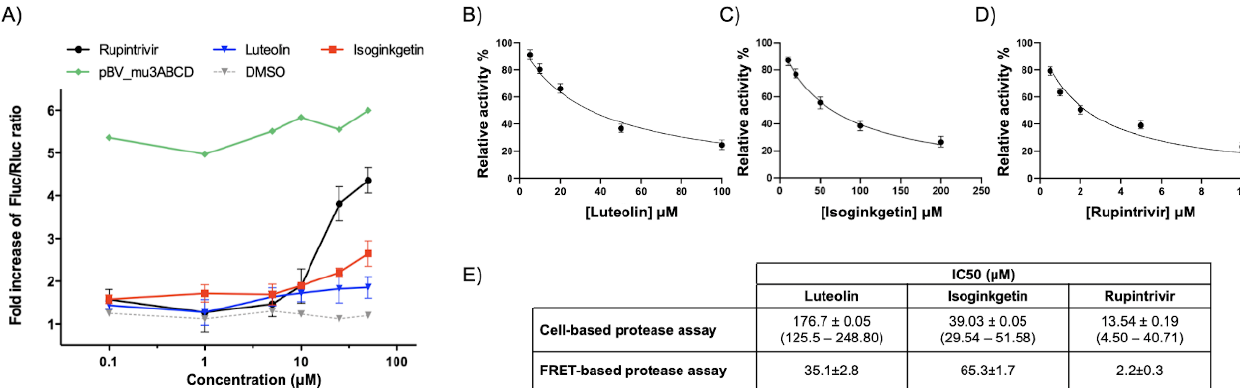
Figure 4. Cell-based and FRET-based protease assay used to evaluate the anti-FMDV 3C pro activities of luteolin and isoginkgetin. pBV_3ABCD containing a gene encoding for the FMDV-3ABCD GAL4-binding domain and VP16 activation domain, and pG5luc reporter plasmid with the GAL4-binding site were co-transfected into HEK293T cells prior to incubating with the 10-fold serially diluted compounds. The firefly (Fluc) and Renilla (Rluc) luciferase levels generated from each treatment was measured and reported as Fluc/Rluc ratios ( A ). The IC50 values of luteolin ( B ), isoginkgetin ( C ), and rupintrivir ( D ) determined by the FRET-based protease assay were measured to be 35.1 ± 2.8, 65.3 ± 1.7, and 2.2 ± 0.3 μM, respectively, based on the inhibitor concentration-dependent curves. The IC50 values obtained from two different protease assay methods were summarized in ( E ).